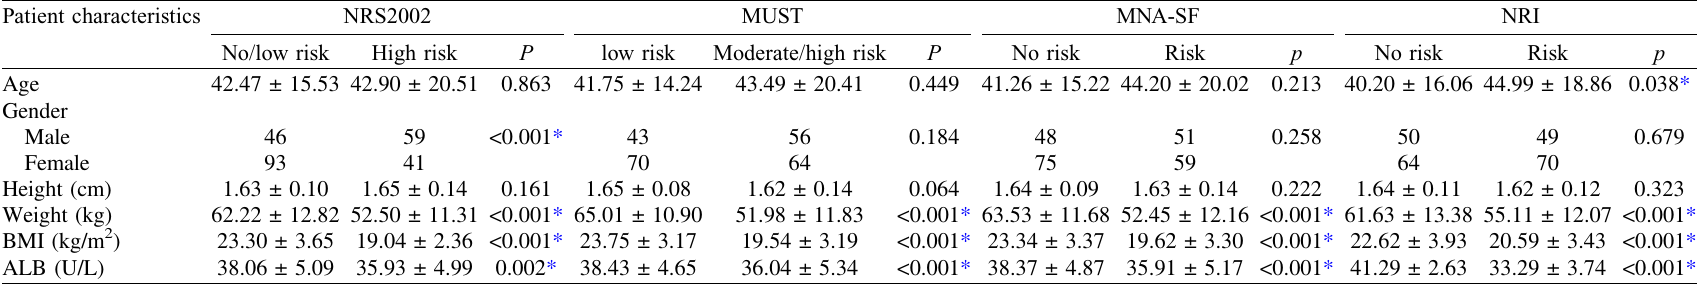
Abbreviations: BMI, Body Mass Index; ALB, Albumin; NRS 2002, Nutritional Risk Screening 2002; MUST, Malnutrition Universal Screening Tool; MNA-SF, Short Form of Mini Nutritional Assessment; NRI, nutrition risk index; ESPEN, European Society for Clinical Nutrition and Metabolism. * Values expressing statistical signi fi cance ( p (cid:3) 0.05).